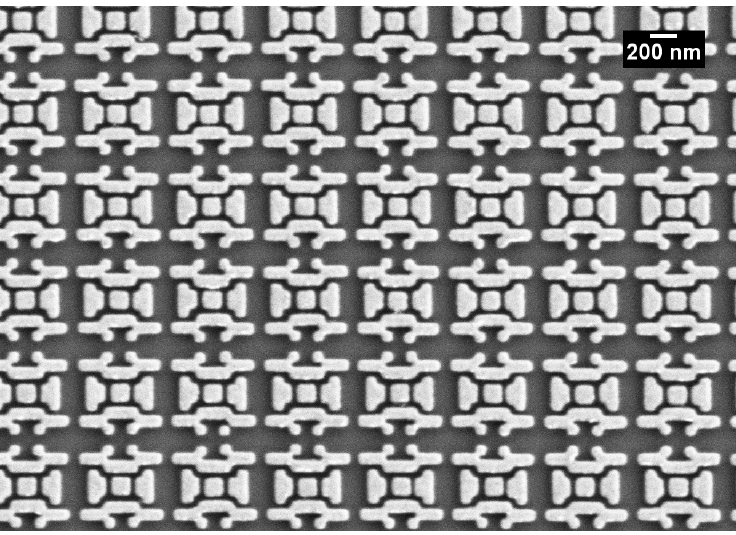
Figure 5. The fabrication result of the optimized SERS substrate captured by a scanning electron micro- scope (SEM). The unit cell was fabricated properly after the optimization of the fabrication